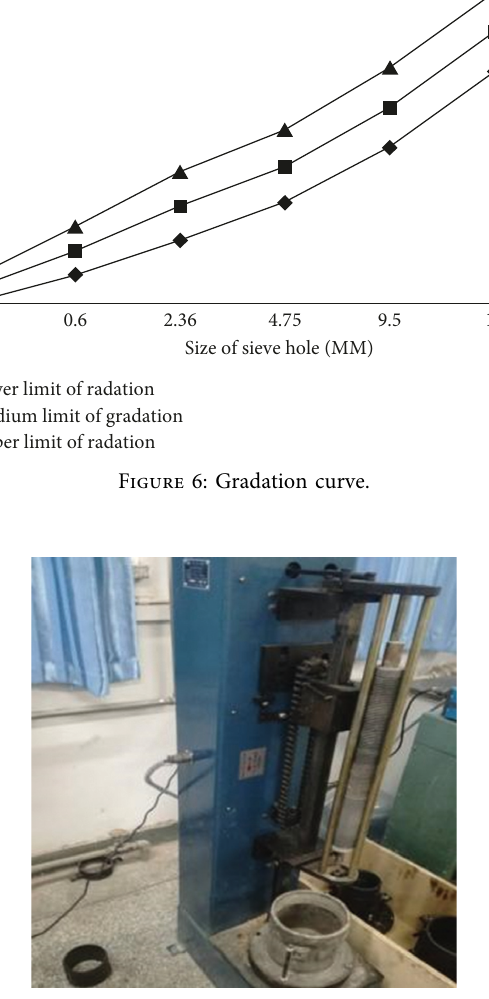
Figure 7: Electric compaction